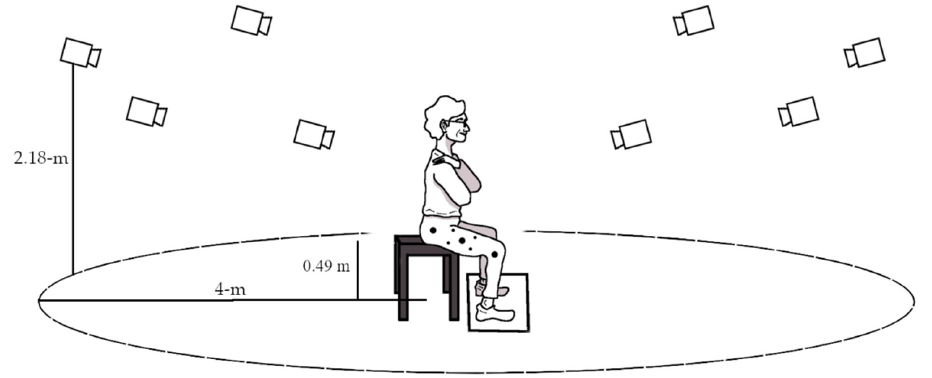
Figure 1. Schematic representation of the data collection setup. The figure represents the position of the lower limbs at the beginning of the test. The participant was sitting on the box with the trunk and shanks positioned perpendicular to the ground. The larger black dots represent the main markers placed on the trochanter, mid-thigh, and lateral epicondyle of the femur (from left to right), respectively. The marker set was completed by a total of 4 additional markers used for signal recovery purposes (smaller black dots) positioned around the mid-thigh main marker. The force platform is represented as the white square under the participant’s feet. A total of 8 cameras were placed at 2.18-m height and 4-m distance around the participant.